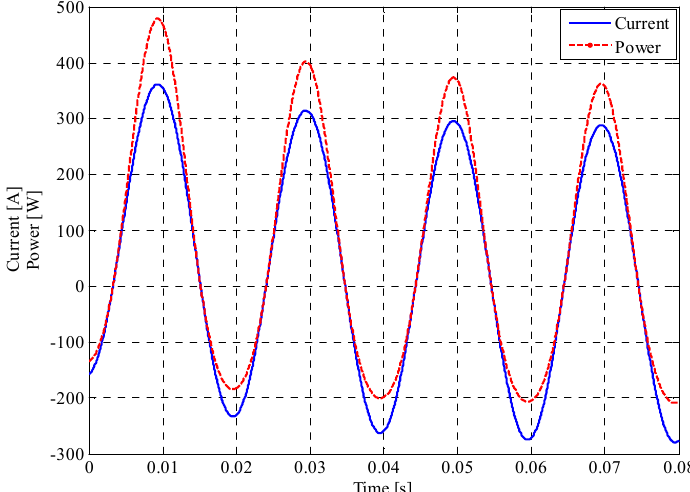
Figure 1. The definition of the firing angle ( α ) and the locking angle ( α b ).